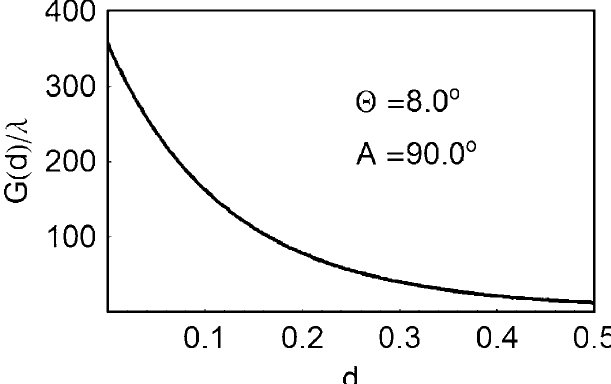
FIG. 8. Typical energy gain over (cid:8) as a function of the electron path separation from the sphere surface, d .